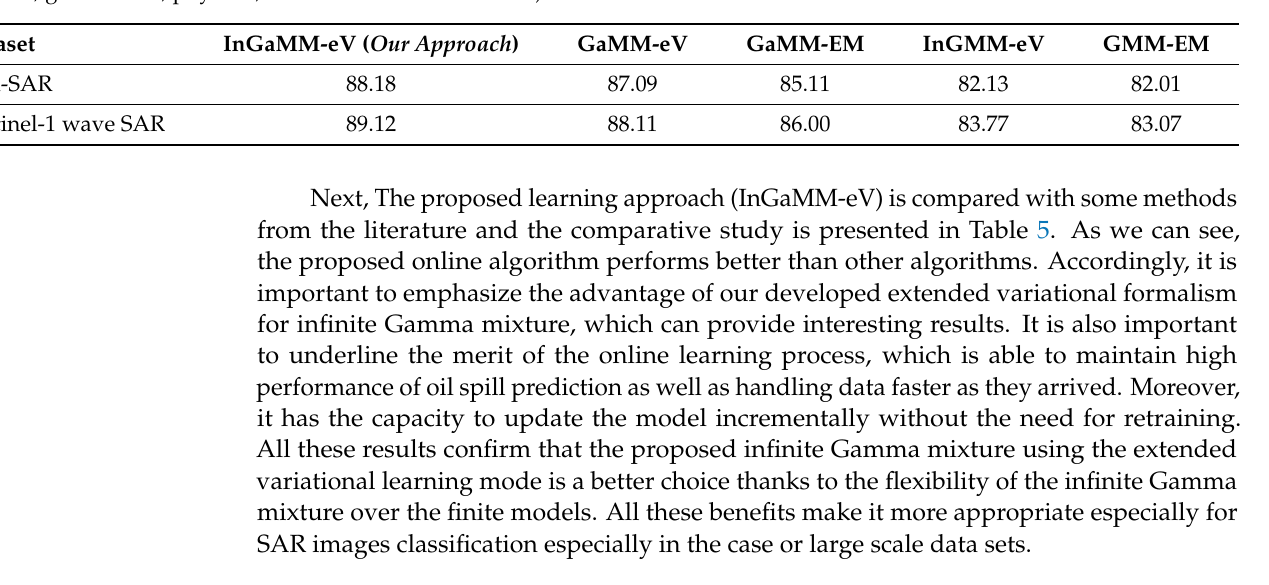
Table 5. Comparative study between different methods from the literature on two